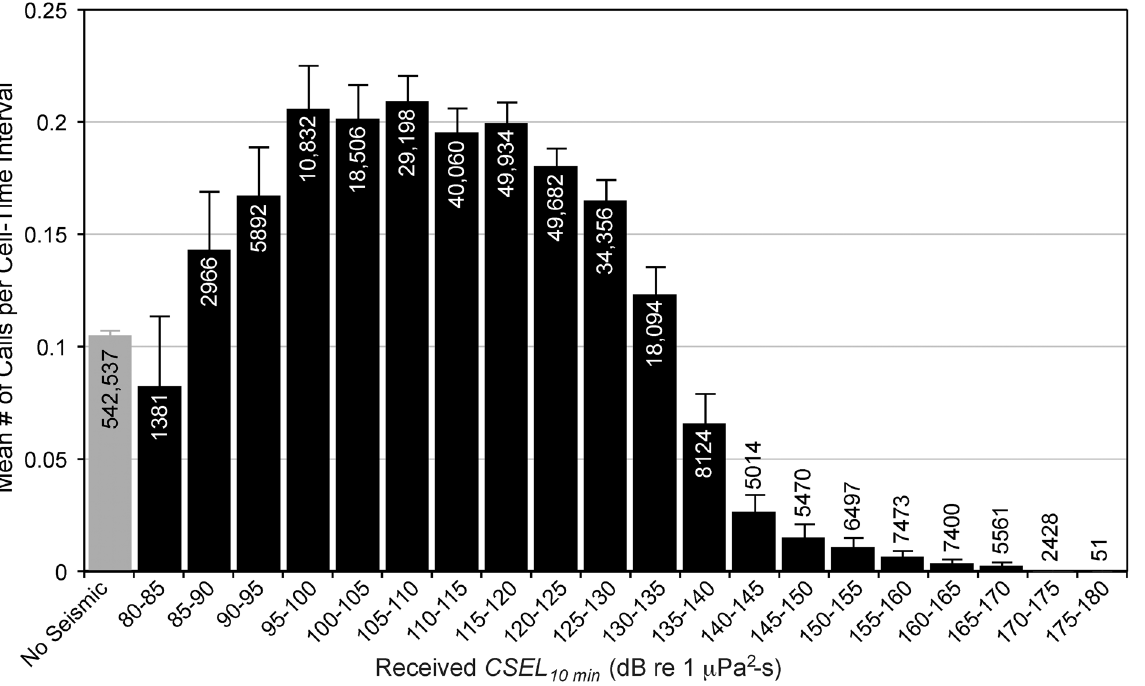
Fig 5. Calls per cell-time interval as a function of received level of sound from airgun pulses. Mean number of localized bowhead calls per cell-time interval for 20 5-dB bins of received CSEL 10-min , as well as a no-seismic category (gray bar) containing all the cell-time intervals without any detected airgun pulses. Upper 95% confidence limits are shown on each bar. Data from all four years and all five sites are included. Sample sizes, i.e., the number of cell-time intervals in each bin, are shown inside or above the bars. Note that this plot excludes 888 cell-time intervals with received CSEL 10-min below 80 dB re 1 μ Pa 2 -s (see